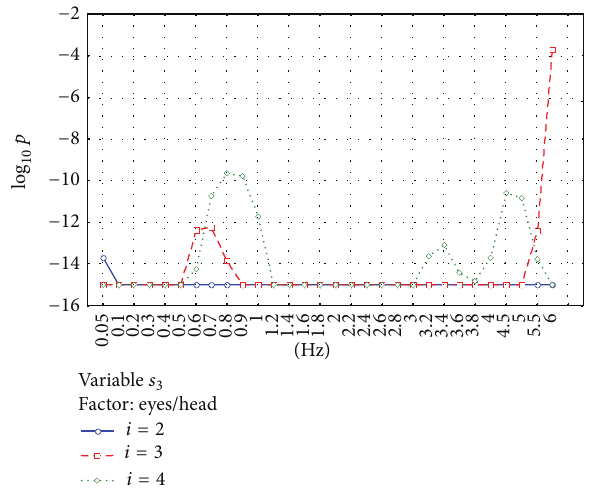
Figure 8: Analysis of the parameter 𝑠 3 . The figure shows the high statistical significance 𝑝 of the main effect in MANOVA analysis for the factor “eyes/head state.” The very high significance is observed for every filter frequency used. The values for eyes closed (E H ) are as a rule lower than for open E C BB